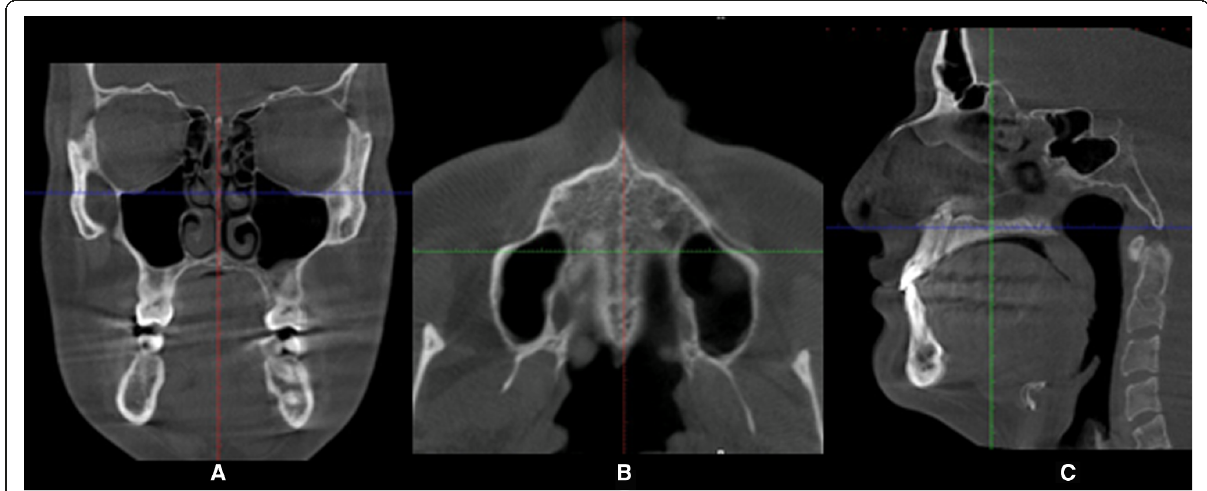
Fig. 1 Procedures in the CBTC sections to measure the midpalatal suture. a Coronal view. b Axial view. c Sagittal view, note in the view that the blue line is positioned through the center of the hard